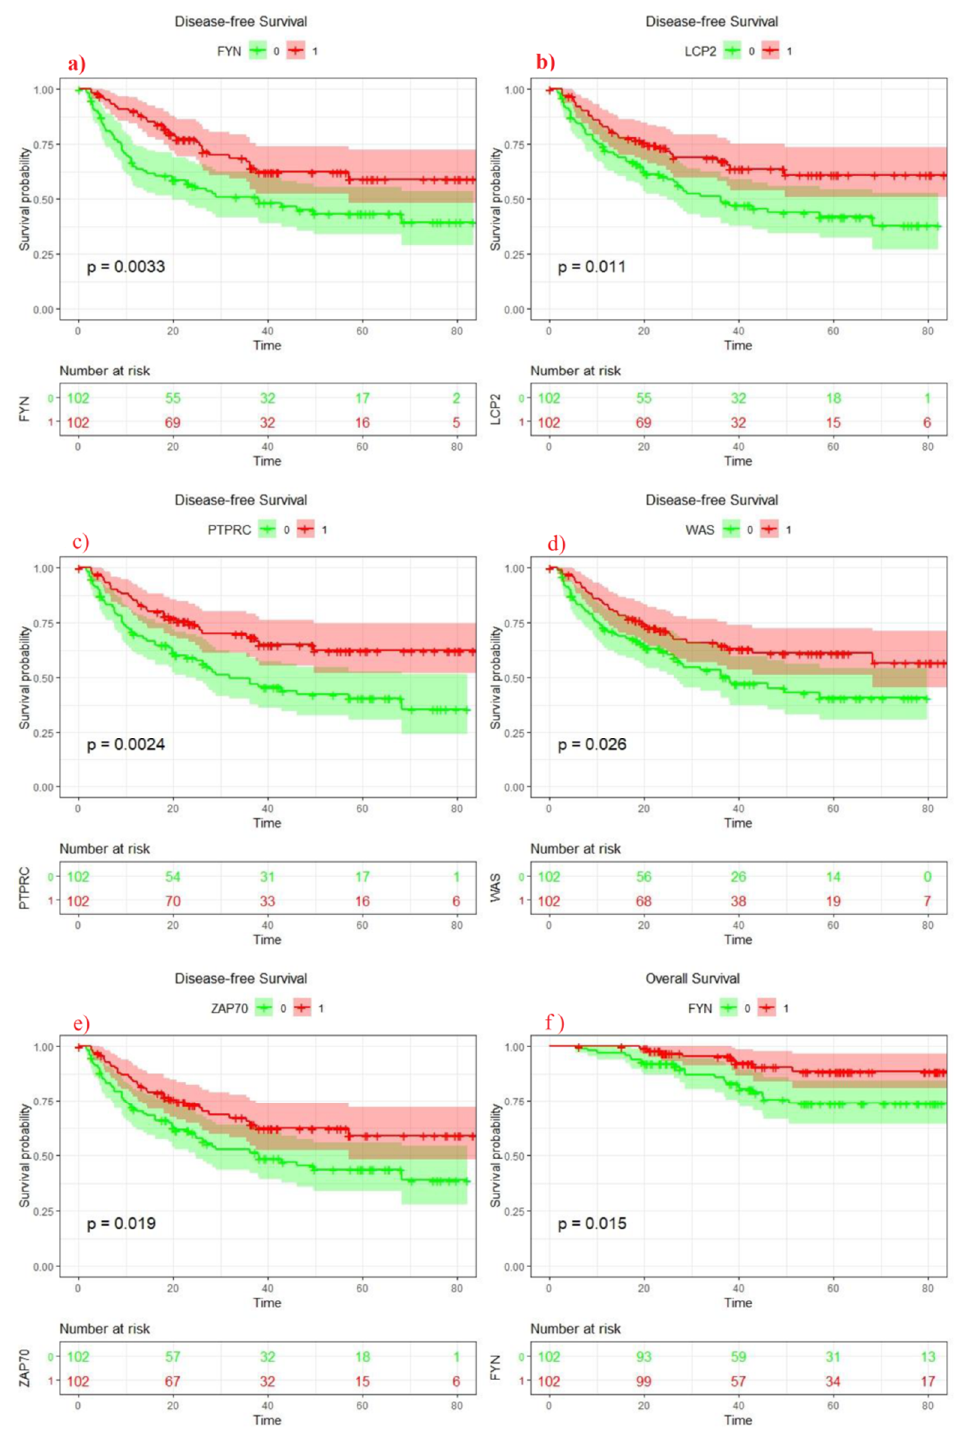
Figure 2. Kaplan–Meier estimates of disease-free survival of ( a ): FYN, ( b ): LCP2, ( c ): PTPRC, ( d ): WAS, ( e ): ZAP70 expression in HCC patients (Discovery cohort). ( f ): Kaplan–Meier estimates of overall survival of FYN gene (Discovery cohort).